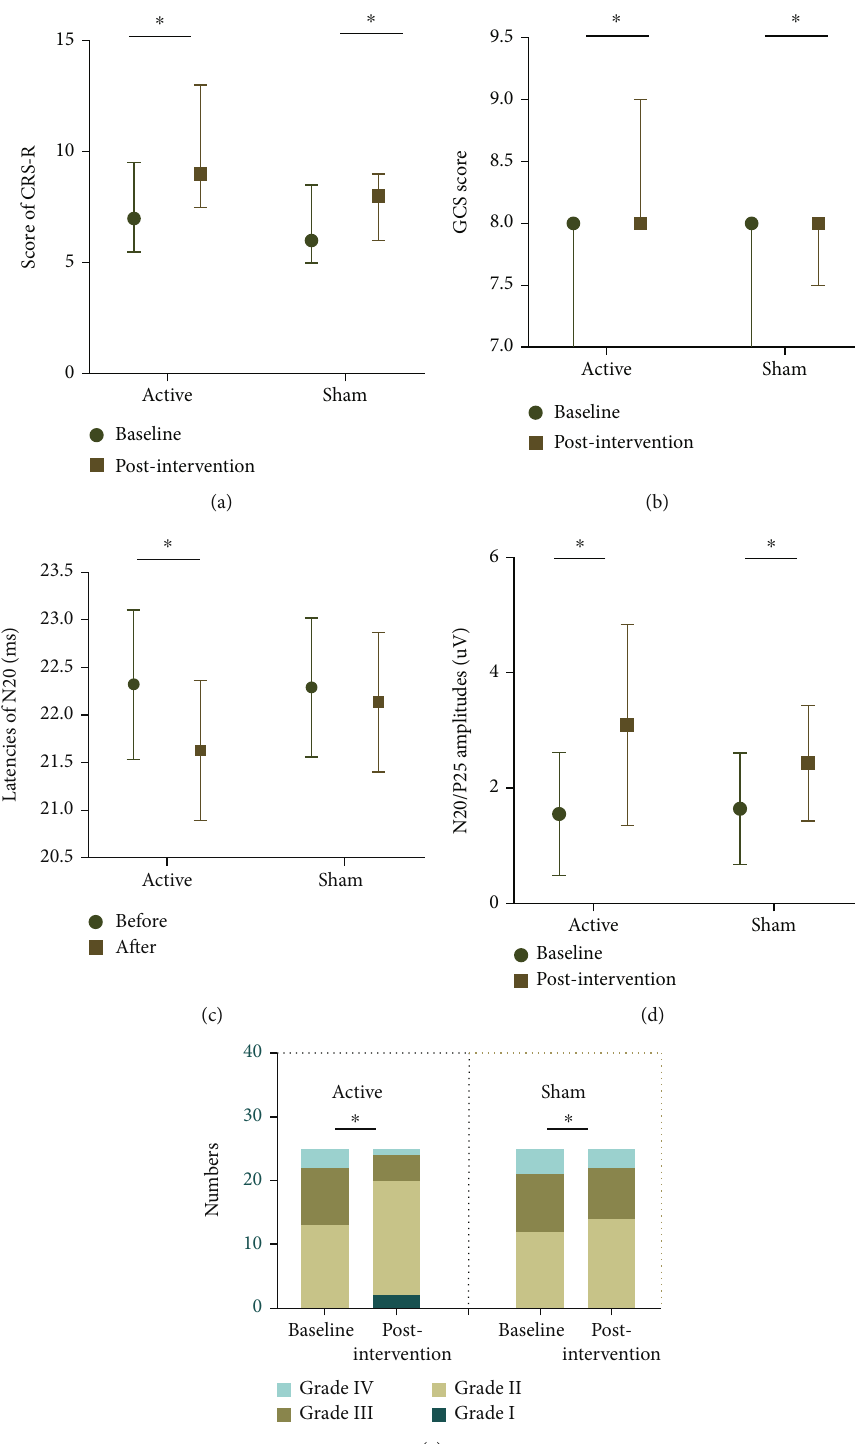
Figure 3: The in fl uence of 30 sessions of active rTMS compared to sham treatment on clinical assessments and electrophysiological evaluation. (a) CRS-R scores poststimulation in both groups were signi fi cantly increased compared to that in baseline; (b) GCS scores poststimulation in both groups were signi fi cantly increased compared to that in baseline; (c) N20 latencies following active rTMS were signi fi cantly shorter compared to that in baseline, while no signi fi cant decrease was produced in the sham group compared with baseline; (d) N20-P25 amplitudes in both groups were signi fi cantly higher compared to that in baseline; (e) BAEP grades in both groups were signi fi cantly improved compared to that in the baseline. ∗ p < 0 : 05 . Abbreviations: CRS-R: Coma Recovery Scale-Revised; GCS: Glasgow Coma